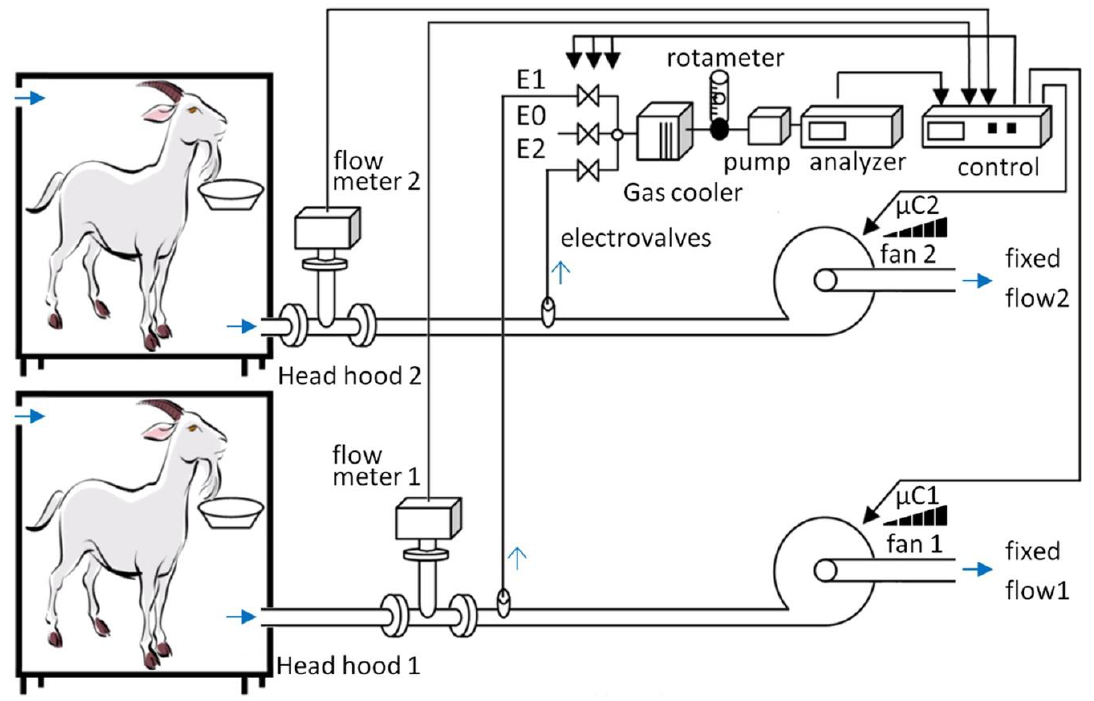
Figure 2. Schematic design of the mobile calorimetry system.